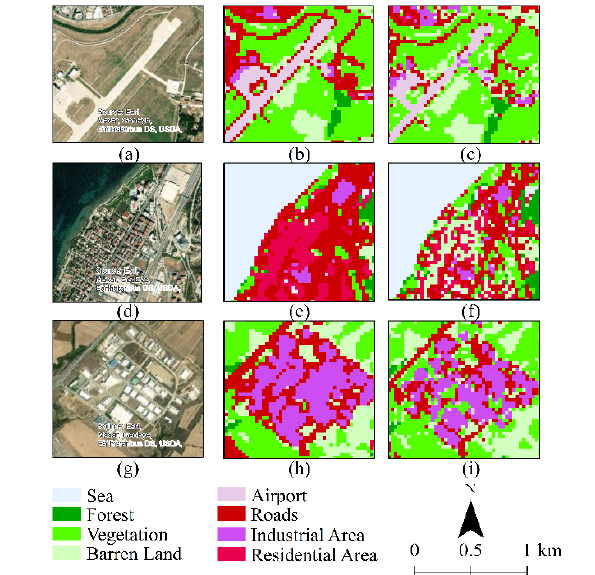
Figure 5. Magnified images of a, d, g reference maps; b, e, h the classification results that were obtained by PRISMA satellite image; c, f, i the classification results that were obtained by Landsat-9 satellite image.